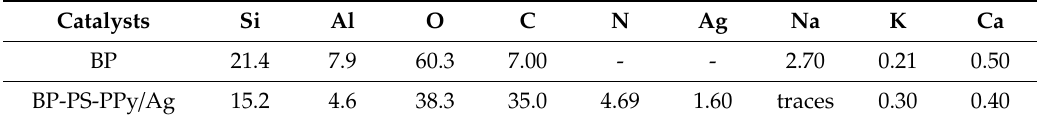
Table 1. Elemental composition determined by XPS.